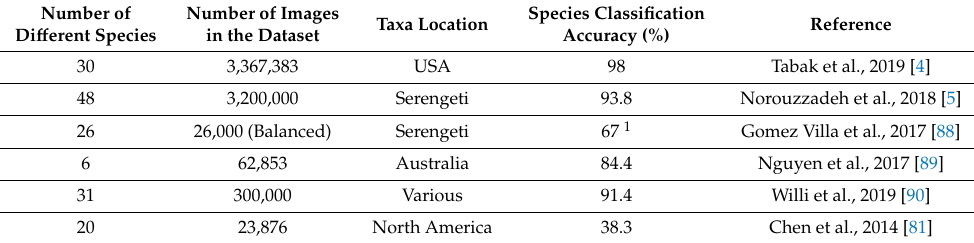
Table 2. Examples of convolutional neural networks (CNNs) use to predict species present in camera trap images. Here, accuracy is defined as the percentage of correct predictions by the network. Accuracy figures refer to the top-performing model, or ensemble of models, from each study. Balanced refers to the fact that there is the same number of images in each species class. No object segmentation or detection was